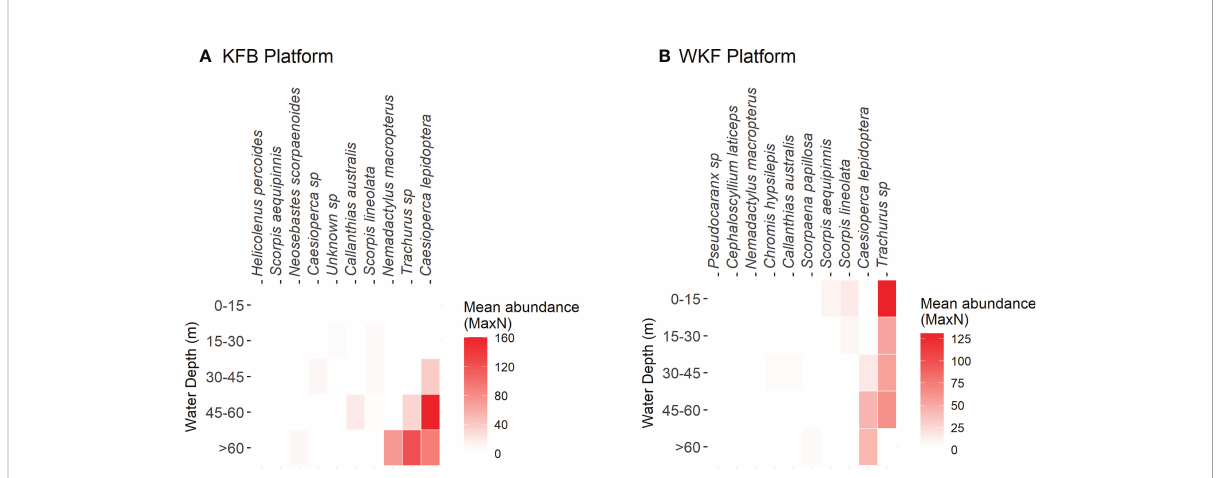
FIGURE 9 Heatmap showing average abundance (mean MaxN) of the ten most abundant species at each of the fi ve depth bands (0 – 15, 15 – 30, 30 – 45, 45 – 60, > 60 m) for each platform King fi sh B (KFB, A ) and West King fi sh (WKF, B